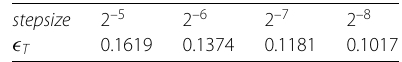
Table 3 Computational error at endpoint T = 1 for Example 5.3 with c = 0.01